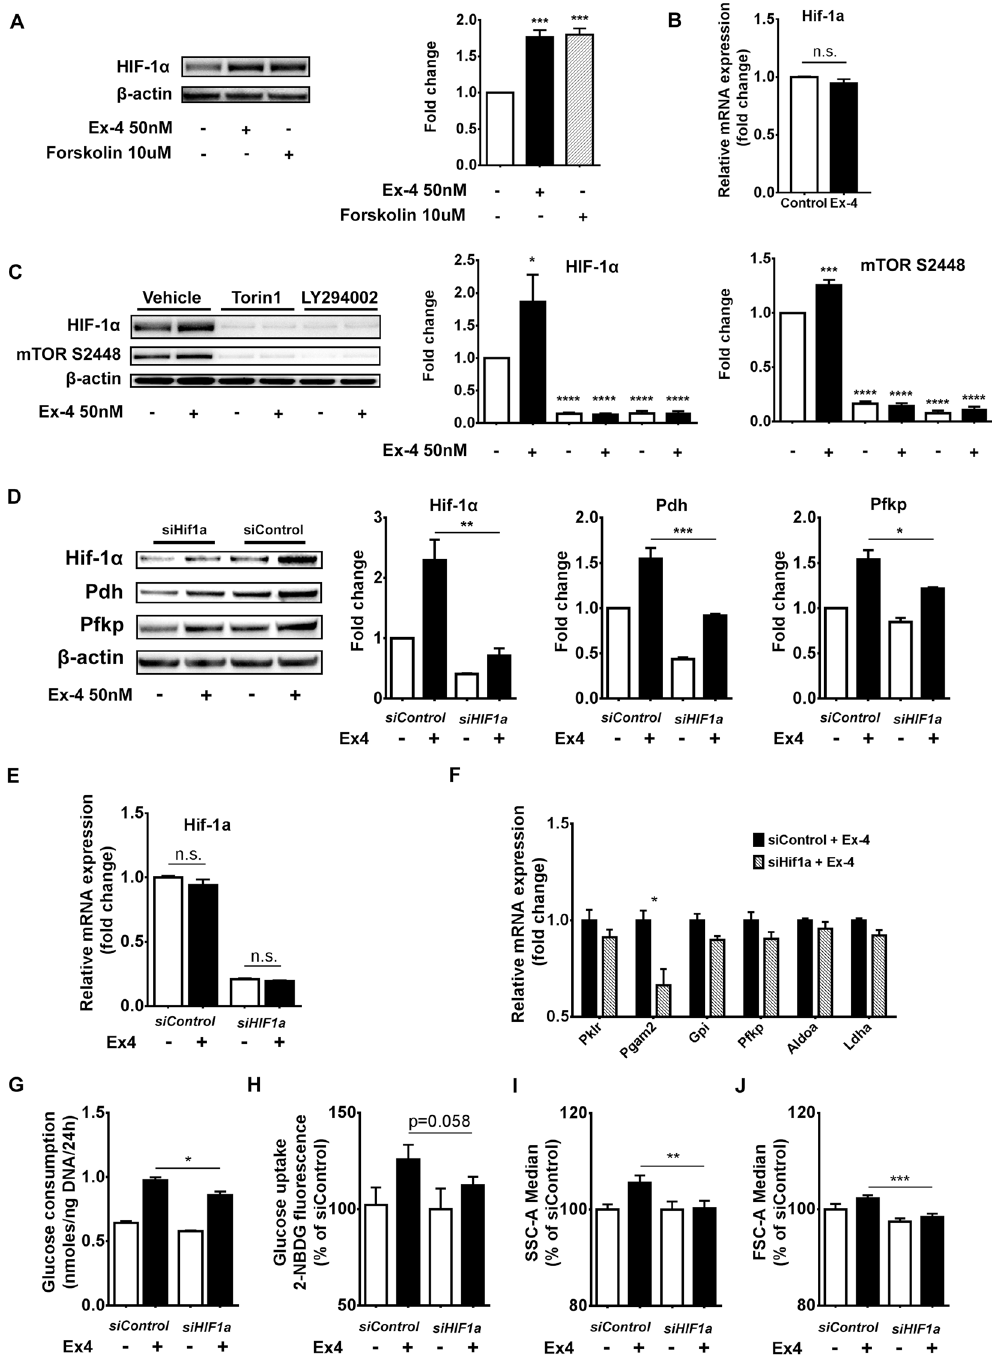
Figure 6. Increase in glucose metabolism induced by GLP-1R signalling is mediated by HIF-1 α . ( A ) BRIN-BD11 cells were treated as indicated for 18 hours and Hif1 α protein levels were determined by immunoblot analysis. ( B ) After treatment with Exendin-4 for 18 hours HIF-1 α mRNA expression was evaluated by qRT-PCR. ( C ) BRIN-BD11 cells were pre-incubated with either vehicle, 1 µ M Torin 1 or 50 µ M LY294002 for 30 min as indicated, followed by addition (or not) of 50 nM Exendin-4 for 18 hours. Immunoblot shows Hif1 α protein expression and phosphorylation levels of mTOR at serine 2448. ( D – J ) BRIN-BD11 cells were transfected with either HIF-1 α specific siRNAs ( siHIF1a ) or non-targeting siRNAs ( siControl ) for 24 h, and subsequently exposed to 50 nM Exendin-4 (or not) for 18 h. ( D ) Exendin-4’s ability to promote protein levels of Pdh and Pfkp was significantly blunted in cells transfected with siHIF1a as compared to siControl transfected cells. ( E ) At the mRNA level, siHIF1a transfection caused a reduction of approximately 80% in HIF-1 α expression. ( F ) mRNA expression of glycolytic enzymes was determined by qRT-PCR analysis. ( G – J ) Determination of glucose consumption, 2-NBDG uptake, SSC-A and FSC-A following HIF-1 α knockdown. Data are mean ± SEM, n ≥ 3; n.s. = non-significant; * P < 0.05; ** P < 0.01; *** P < 0.001; **** P <